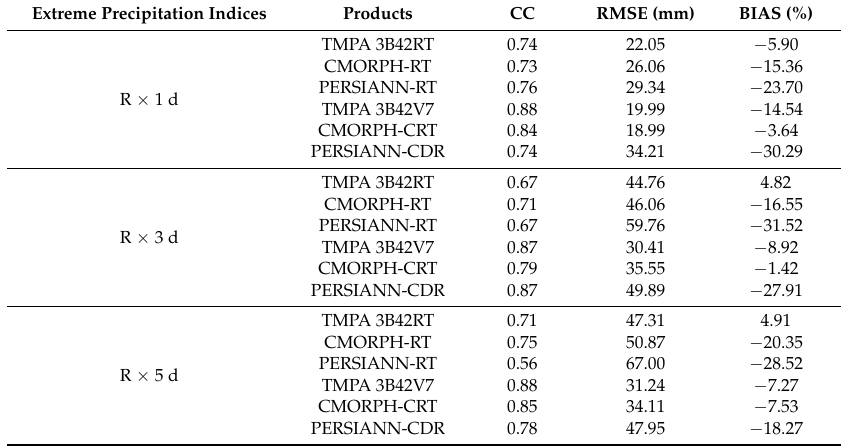
Table 4. Statistical measures of the SPPs for annual maximum 1-, 3-, and 5-day